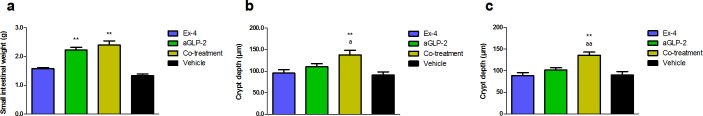
Co-treatment with Ex-4 and aGLP-2 exerts synergistic trophic effects in normal healthy mice.a Small intestinal weight (g), b crypt depth in duodenum, c crypt depth in jejunum.Results are shown as mean ± standard error of the mean. n = 8. **p<0.01 compared to vehicle, a = p<0.05, aa = p<0.01 compared to aGLP-2 treatment (ANOVA followed by Dunnett or Bonferroni multiple comparison test).